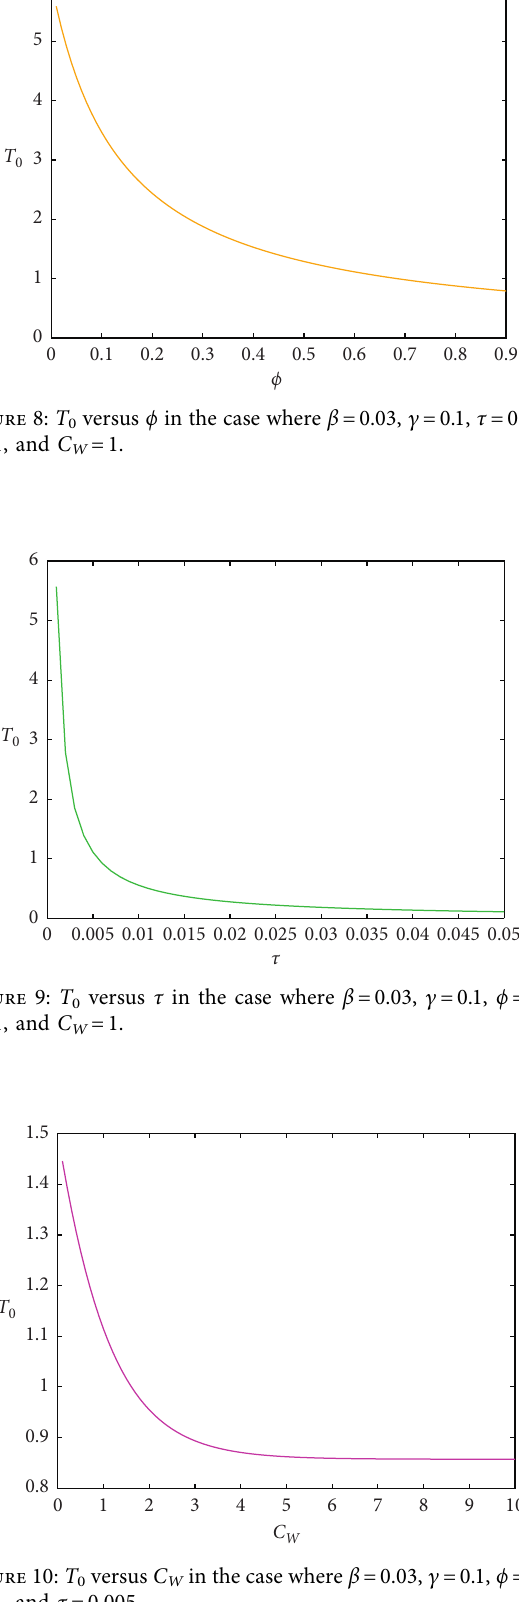
� 0.03, c � 0.1, ϕ � 0.6,